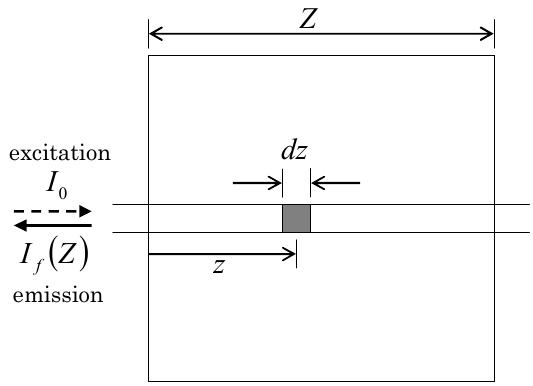
Fig. 1 Schematic of absorption and emission of fluorescent dye solution